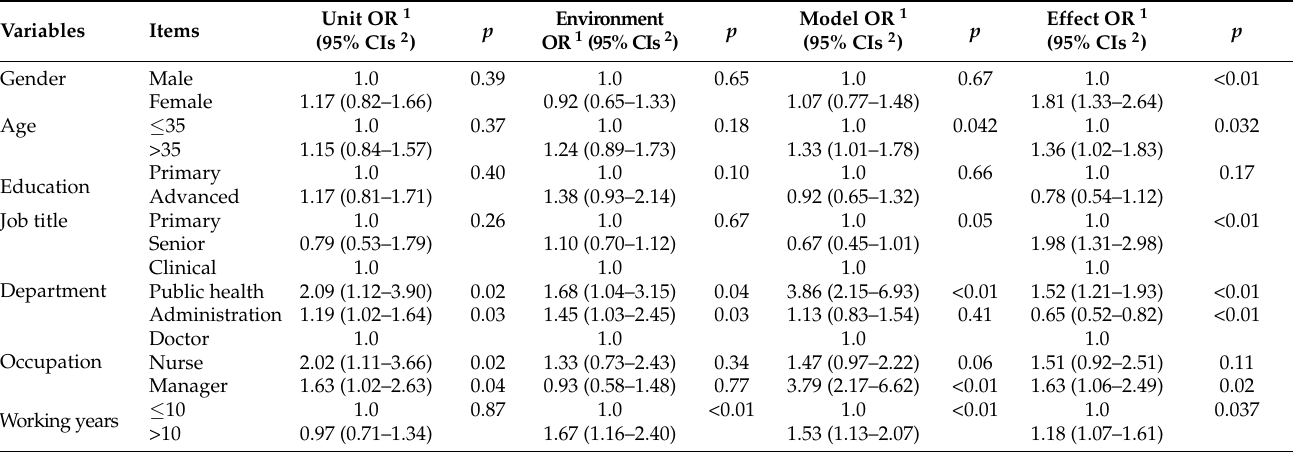
Table 6. Binary logistic regression analysis of the symbiotic unit, environment, model, and effect of the integration of medical care and disease prevention.